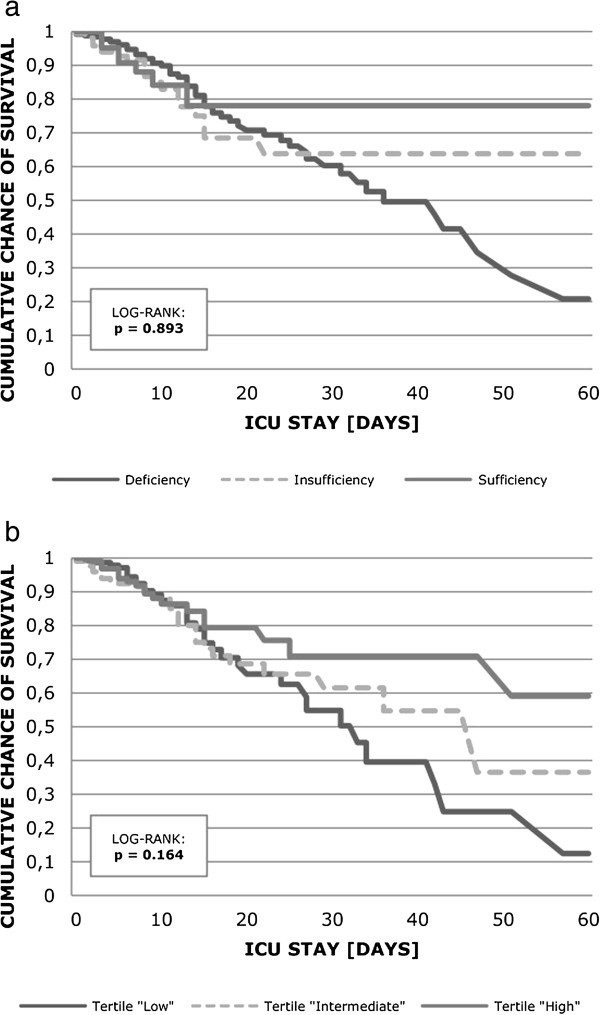
Unadjusted Kaplan-Meier plot for ICU survival stratified by definition of vitamin D deficiency (a) and month-specific vitamin D tertiles (b). Using the log-rank test, ICU mortality was not significantly different between groups (P = 0.893 for vitamin D sufficiency/insufficiency/deficiency classification and 0.164 for tertiles).